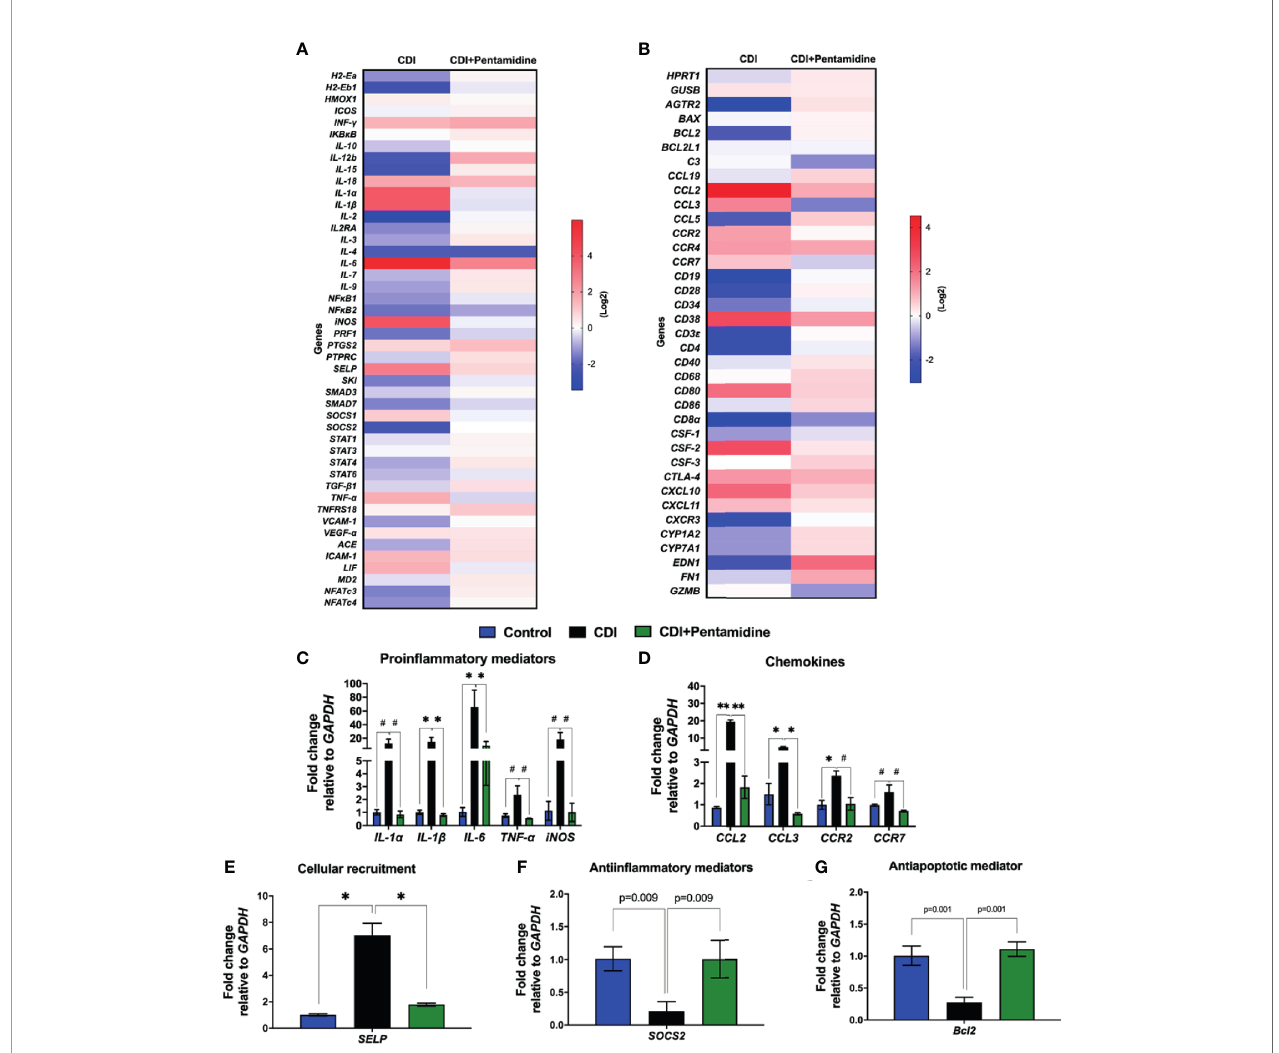
FIGURE 4 | S100B inhibition upregulates anti-in fl ammatory ( SOCS2 ) and antiapoptotic mediators ( Bcl2 ) and downregulates in fl ammatory mediators during CDI. (A, B) Heat map of the cDNA microarray analysis of colonic tissues from non-pretreated C. dif fi cile -infected (CDI) and pentamidine-pretreated C. dif fi cile- infected (CDI+pentamidine) mice at day 3 p.i. Expression of the genes is normalized to median of the control, log 2 scale. TaqMan qPCR analysis of (C) proin fl ammatory (D) chemokine, (E) cellular recruitment ( SELP ), (F) anti-in fl ammatory SOCS2 , and (G) antiapoptotic Bcl2 mediators. Data are mean ± s.e.m. (C – E) # p < 0.05, *p < 0.01, **p < 0.001. ANOVA followed by Turkey test was